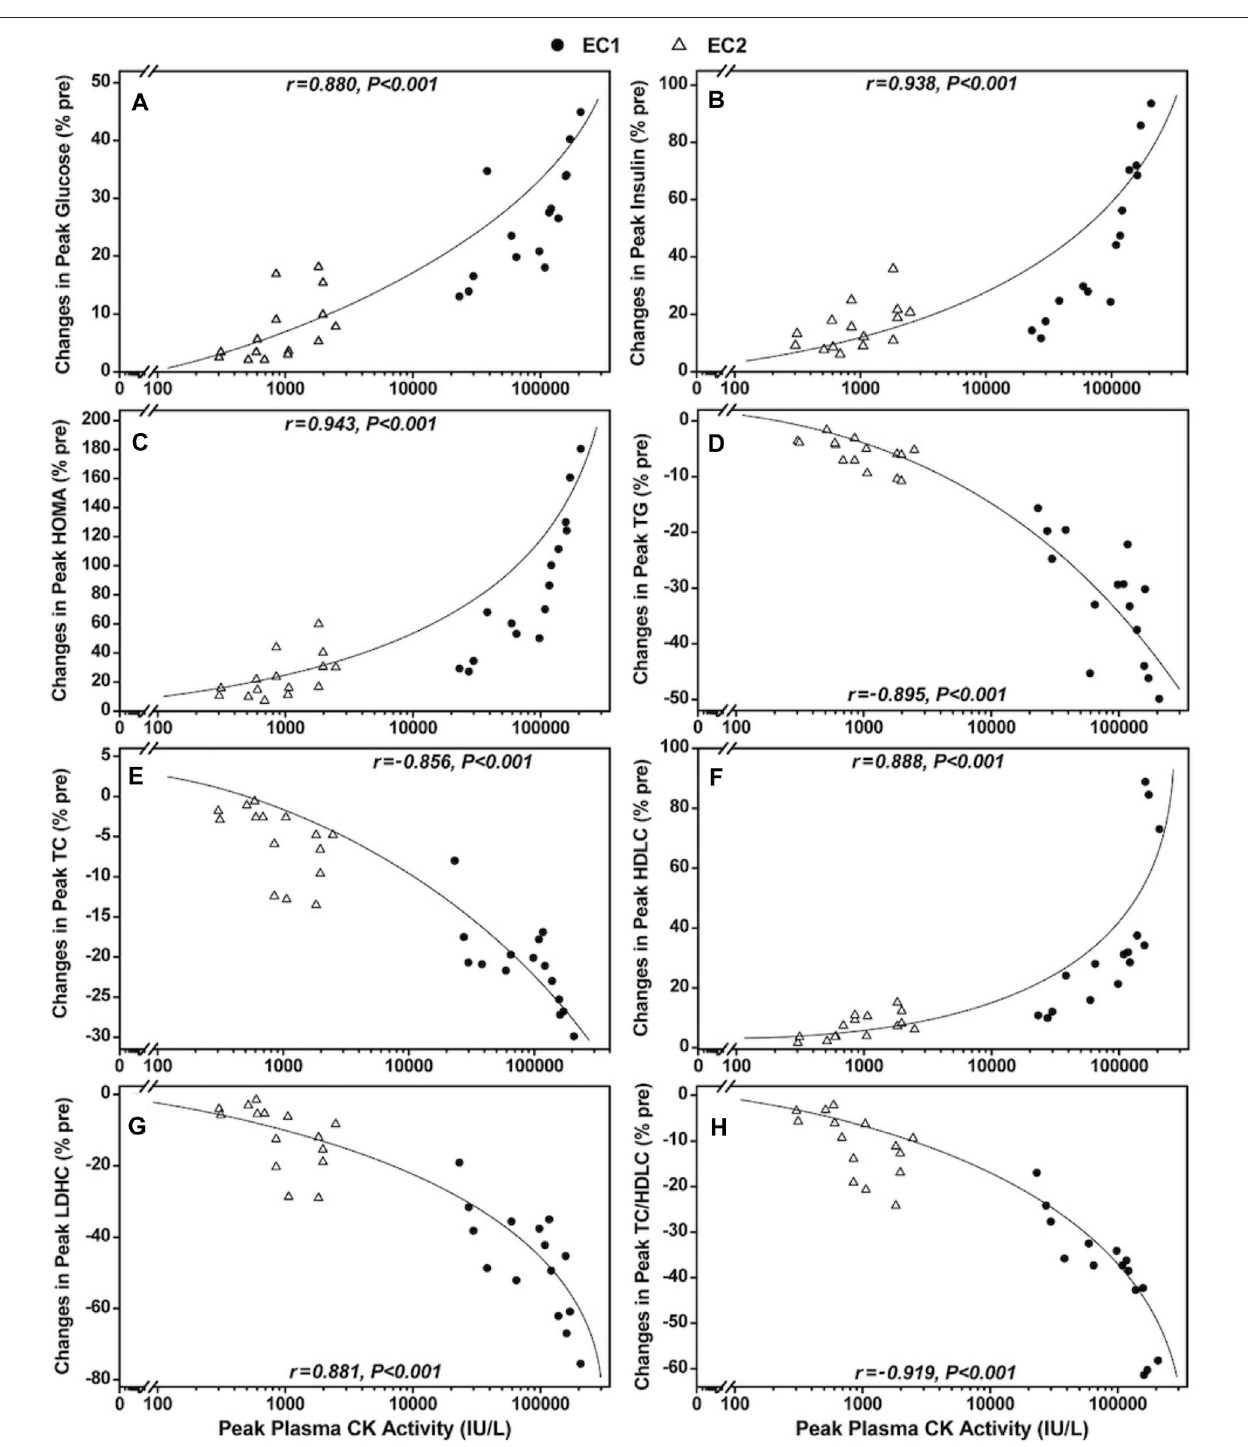
FIGURE 2 | Correlations between peak plasma creatine kinase (CK) activity and peak changes in serum glucose (A) , insulin (B) , homeostasis model assessment [HOMA, (C) ],triacylglycerols[TG, (D) ], total[TC, (E) ] and low- [LDLC, (F) ] and high-densitylipoprotein cholesterols [HDLC, (G) ] concentrationsaswell asTC/HDLCratio (H) and following the fi rst ( C ) and second ( Δ ) bouts of whole-body eccentric exercises (N = 30).